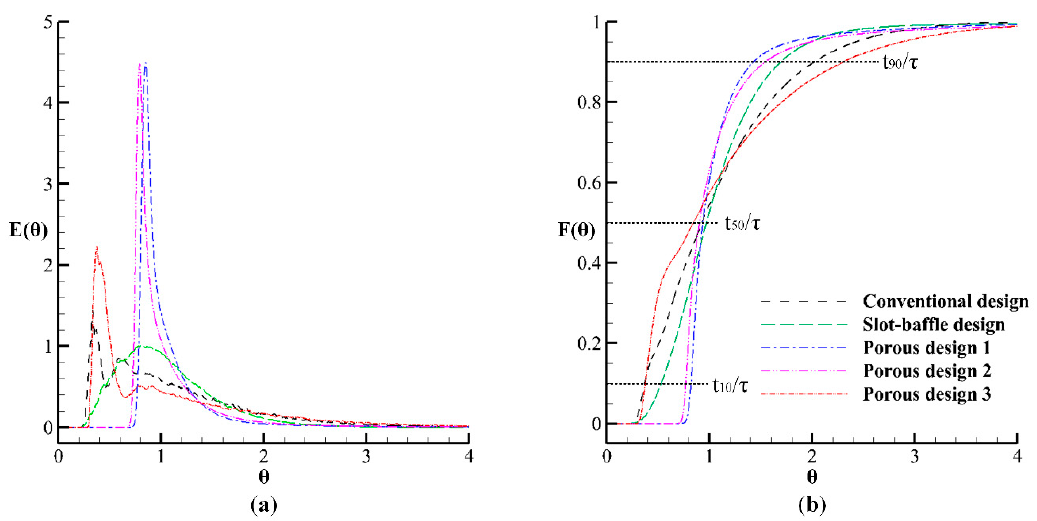
Figure 5. ( a ) Residence Time Distribution (RTD) and ( b ) cumulative RTD plots.